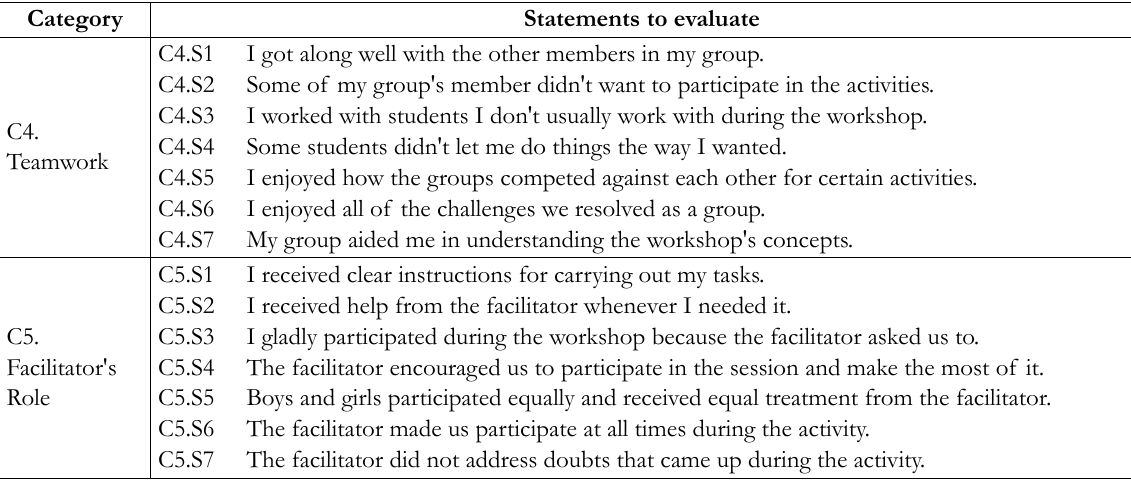
Table 3. Workshop assessment questionnaire (C=category, S=statement)